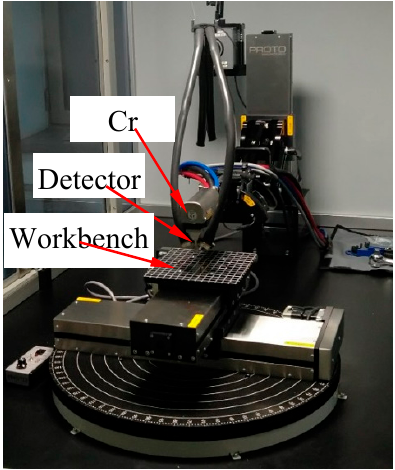
Figure 3. iXRD stress analyzer.